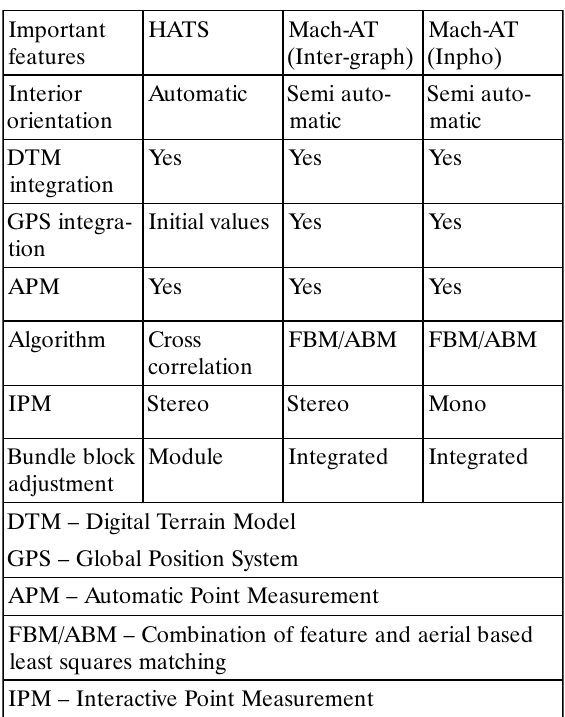
Table . Technical possibilities of software used for